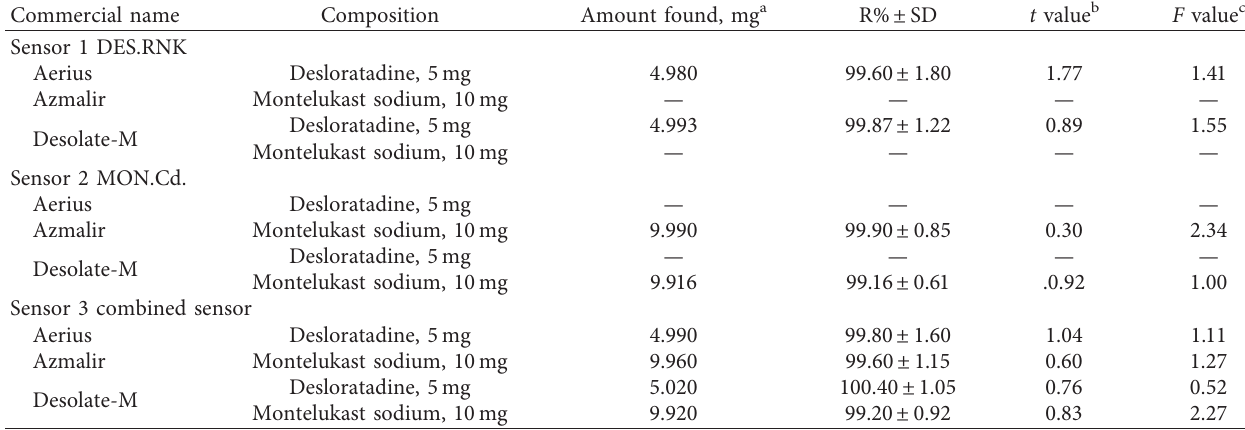
Table 5: Determination of DES and MON in pharmaceutical preparations by the constructed sensors and reported